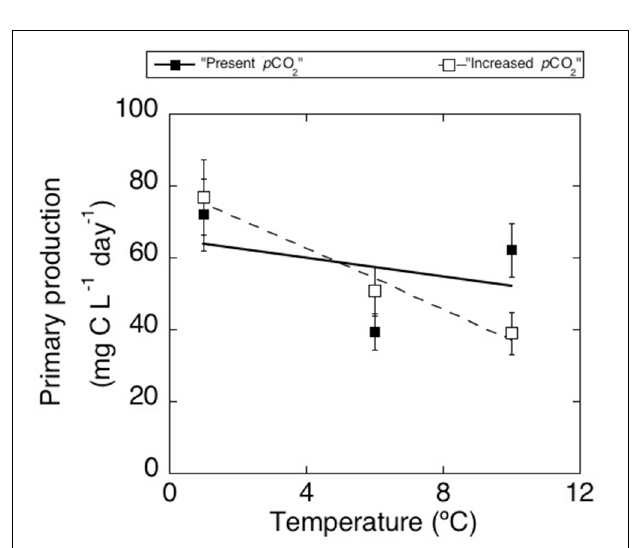
FIGURE 2 | Final values of chlorophyll a concentration in each treatment with their correspondent standard errors.